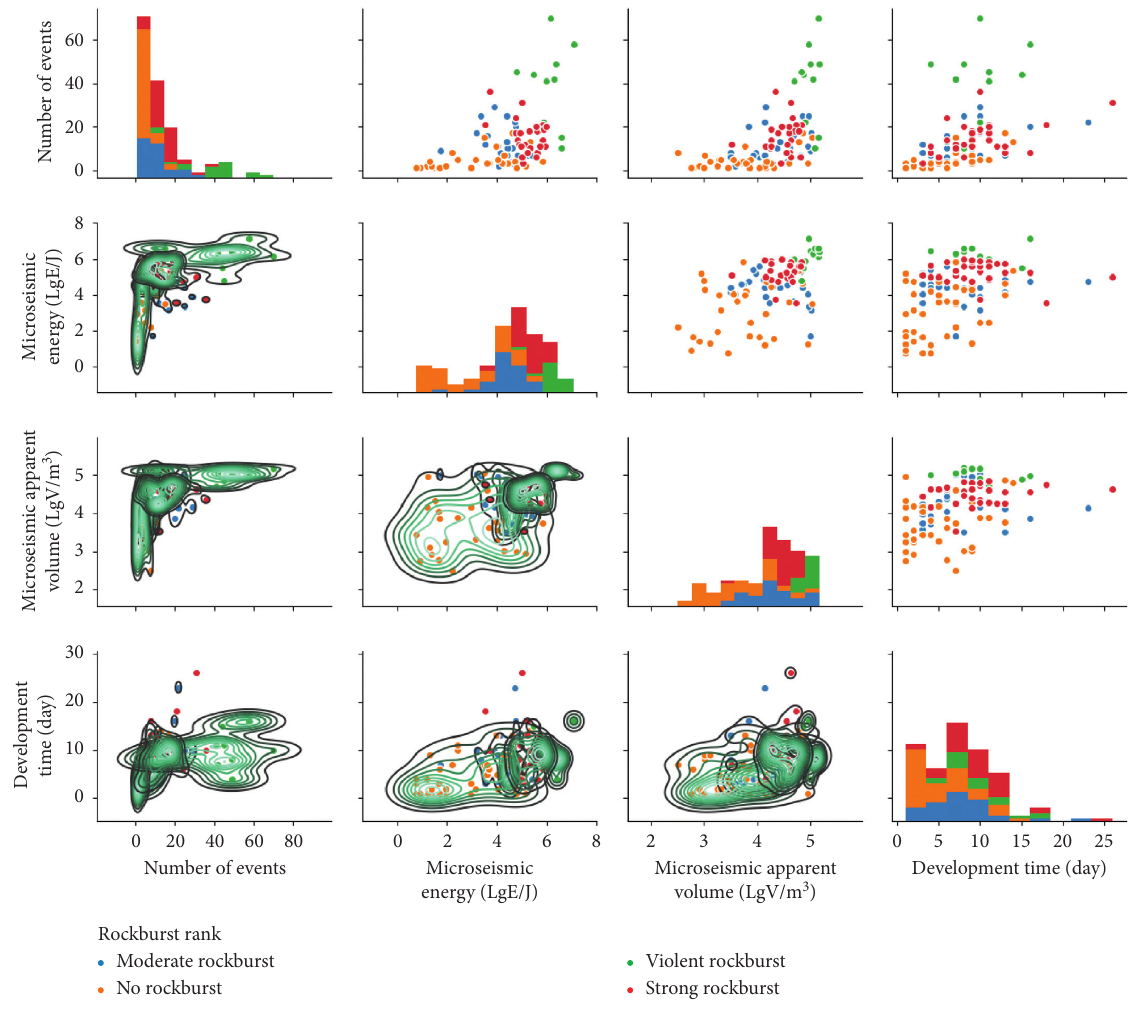
Figure 3: Bivariate relationship of microseismic parameters with the rockburst rank. Table 1: Predicted results of test samples using the decision